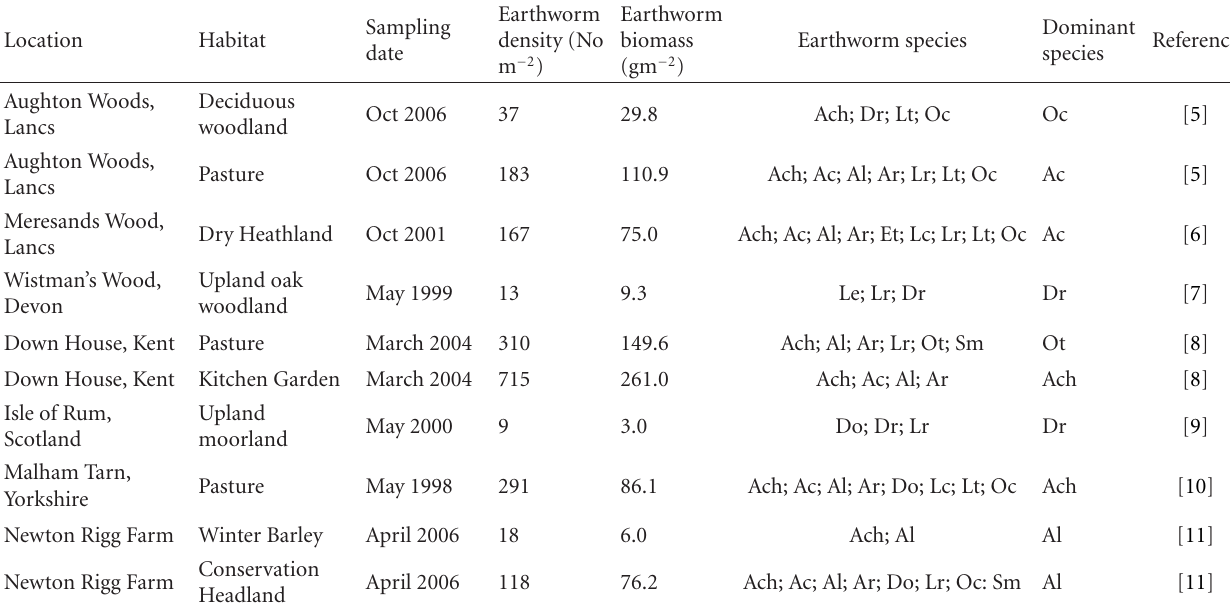
Table 1: Recent British examples of earthworm density/biomass/community structure from sampling with the same techniques (digging and application of a mustard